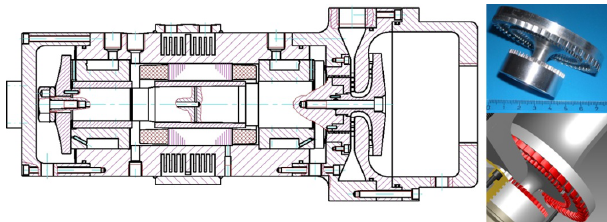
Figure 5: General design of the turbogenerator developed for the ORC cycle